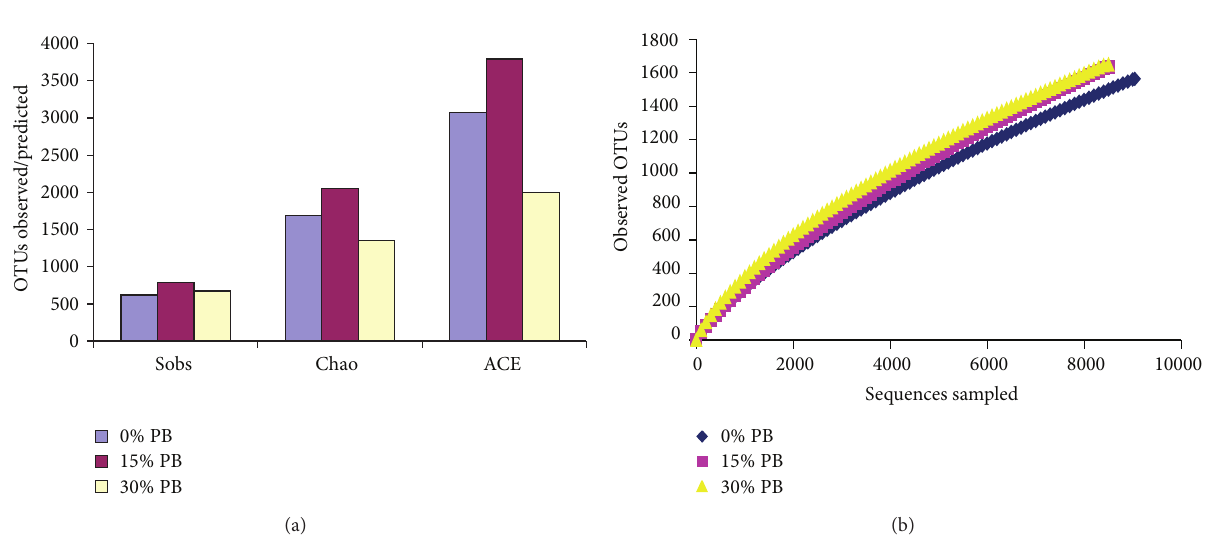
Figure 1: Bacterial richness/diversity estimator (a) and rarefaction curves (b) presented as calculated by MOTHUR at a level of 3% dissimilarity. 0% PB (control), 15% PB, and 30% PB on an as-fed